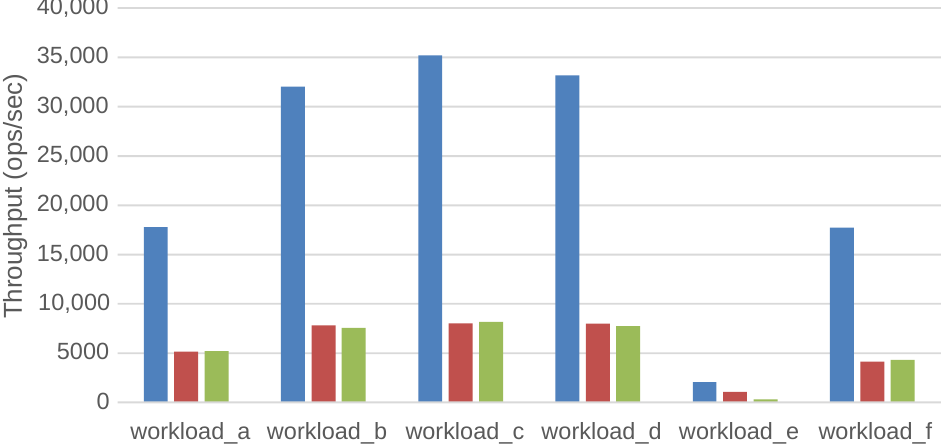
Figure 7. Impact of the deployment configuration on the throughput when the data fits in the cache of a stand-alone MongoDB